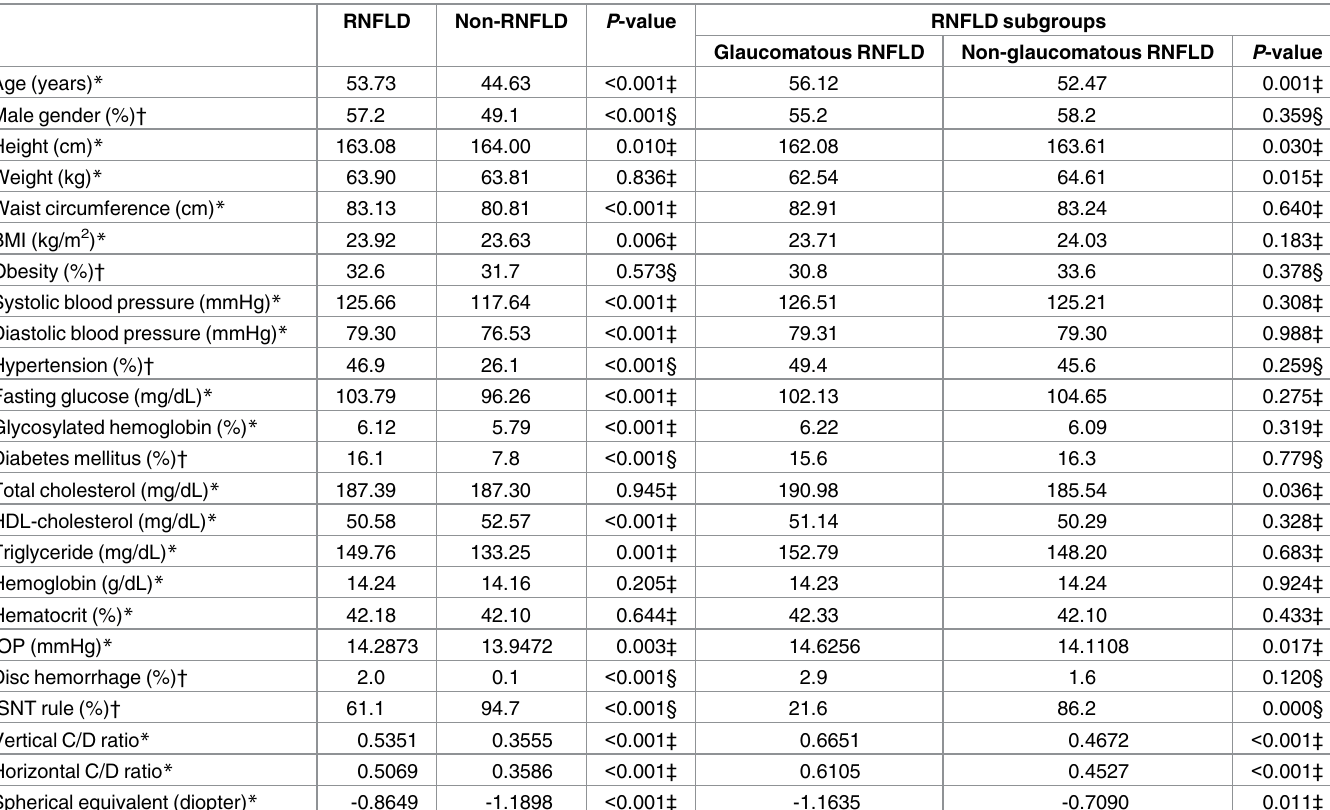
Table 3. Systemicand ocular parameters of the retinal nerve fiber layer defect (RNFLD) group and the non-RNFLD